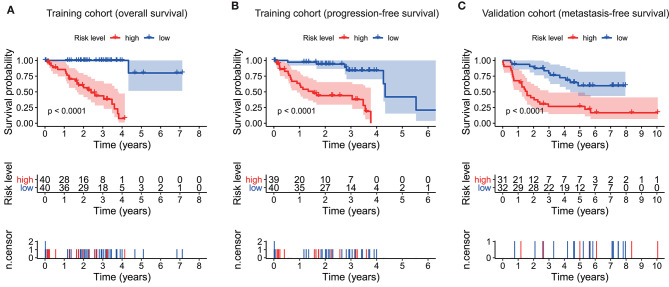
Kaplan–Meier survival analyses based on the ten-gene signature. (A) Training cohort based on overall survival. (B) Training cohort based on progression-free survival. (C) Validation cohort based on metastasis-free survival. Differences between curves were detected by two-side log-rank test.